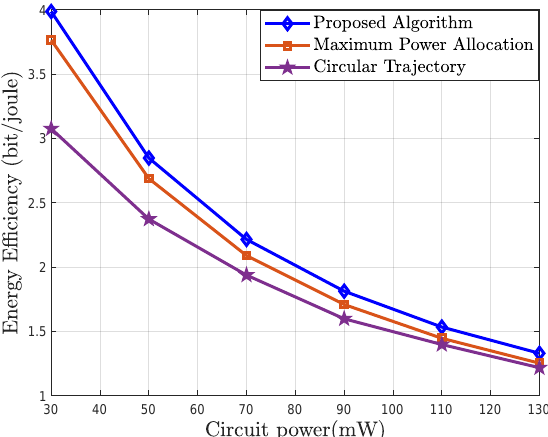
Figure 4. Maximum EE versus the circuit power in compared proposed solution to maximum power allocation and circular trajectory when N = 5, L = 5.